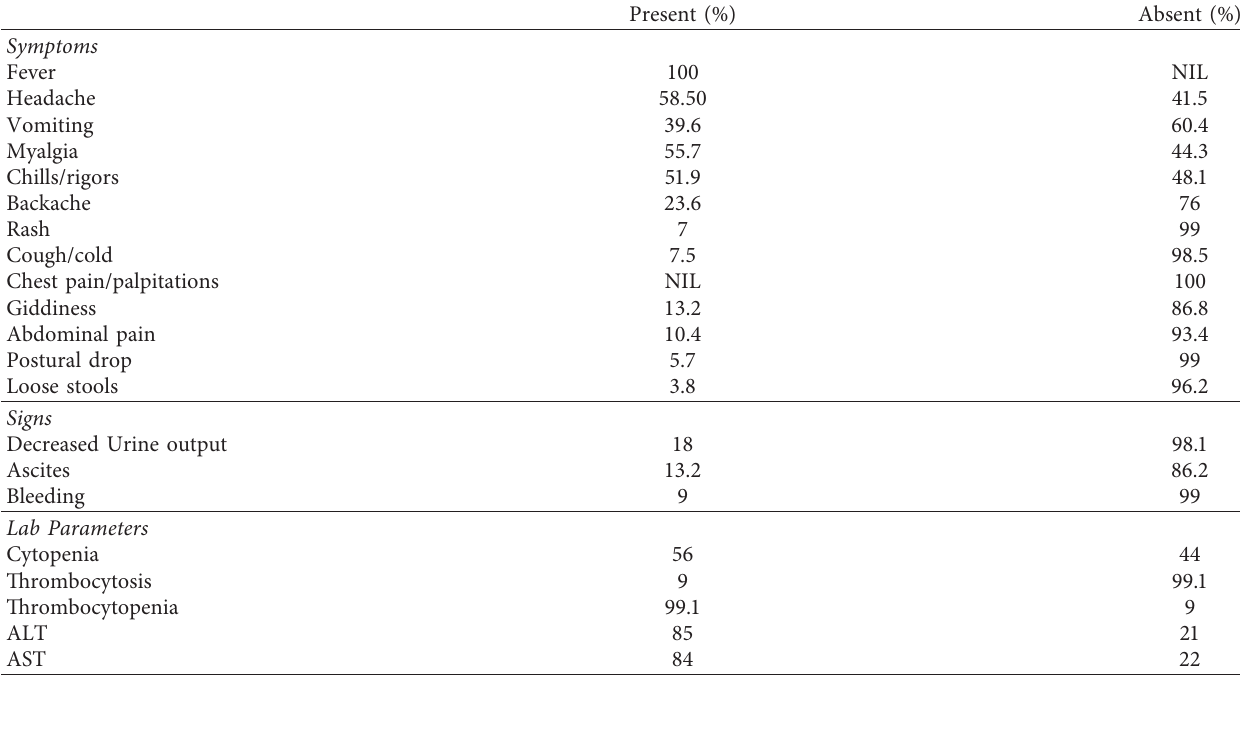
Table 1: Clinical and laboratory profile in dengue infection.